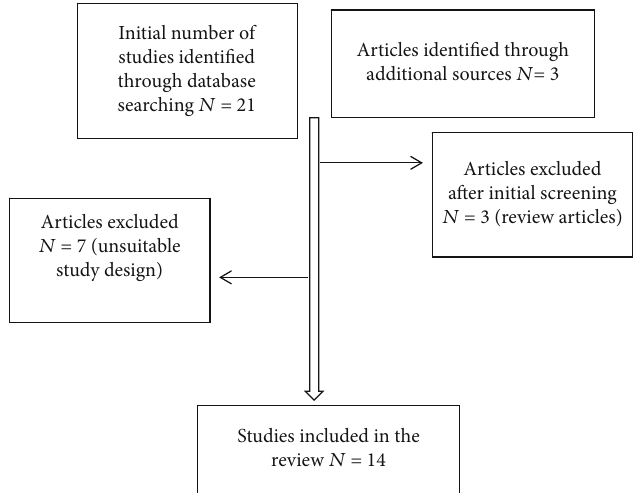
Figure 1: Flow diagram of studies assessed for the